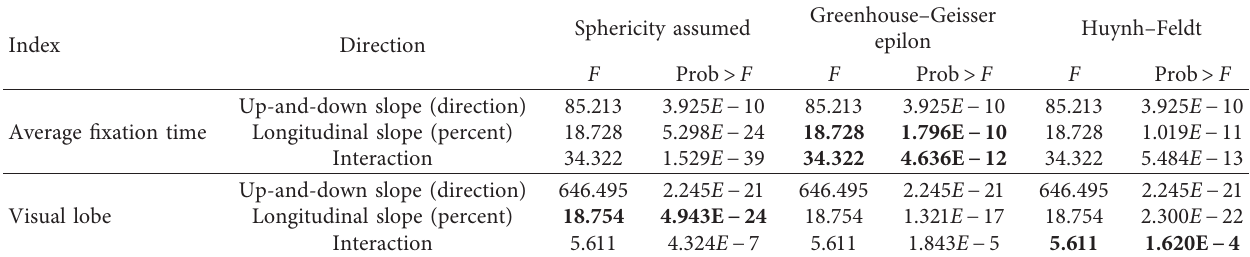
Table 7: Tests of within-subject effects (two -way repeated measures ANOVA).